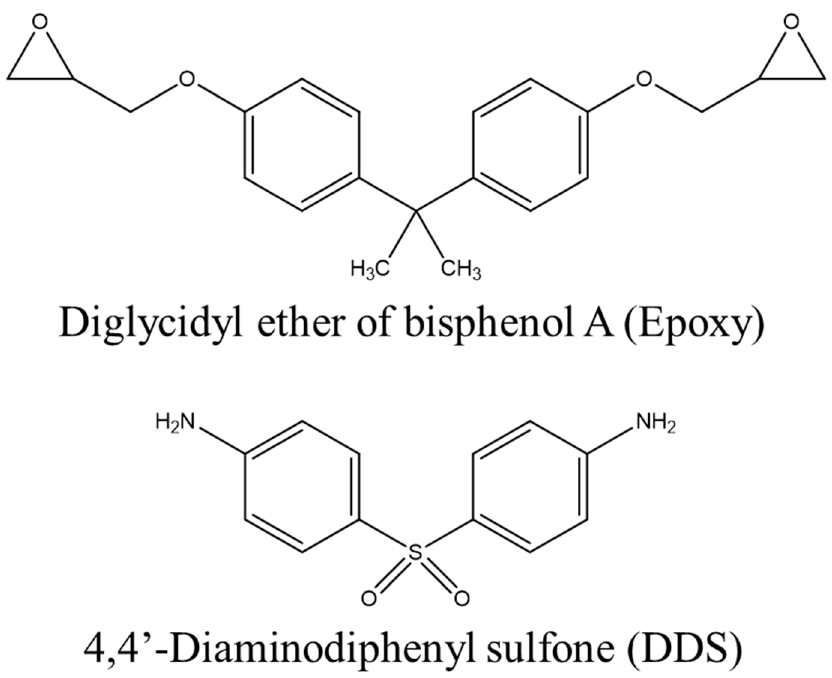
Figure 2. Chemical structures of epoxy and 4,4 ′ -diaminodiphenyl sulfone.